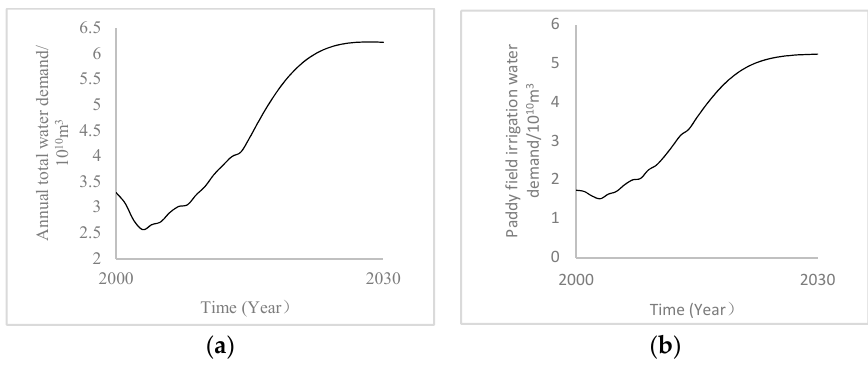
Figure 8. Influential factors of the annual total water demand. ( a ) Annual total water demand; ( b ) Paddy field irrigation water.